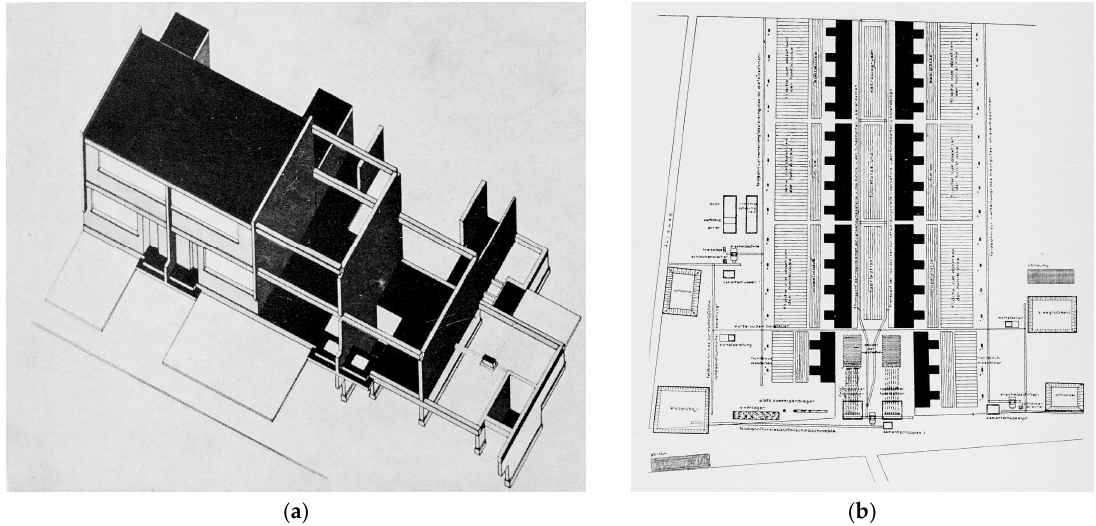
Figure 16. Walter Gropius: Dessau-Törten Housing, 1926–1928—Structural diagram and construction site diagram. Drawings from (Gropius 1930, p. 161, 170).